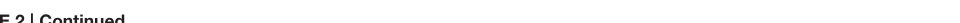
Frontiers in Molecular Neuroscience |